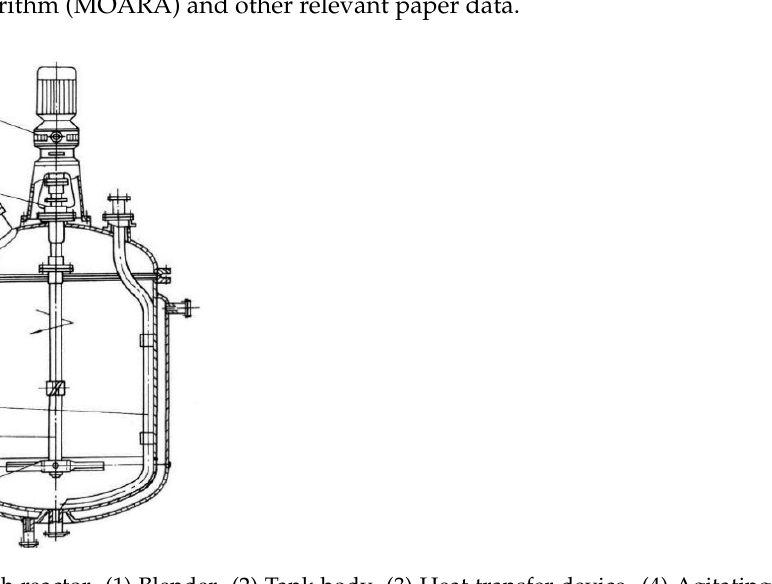
Figure 21. Batch reactor. (1) Blender. (2) Tank body. (3) Heat transfer device. (4) Agitating shaft. (5) Shaft sealing device. (6) Bearing. (7) Manhole. (8) Shaft seal. (9) Transmission.